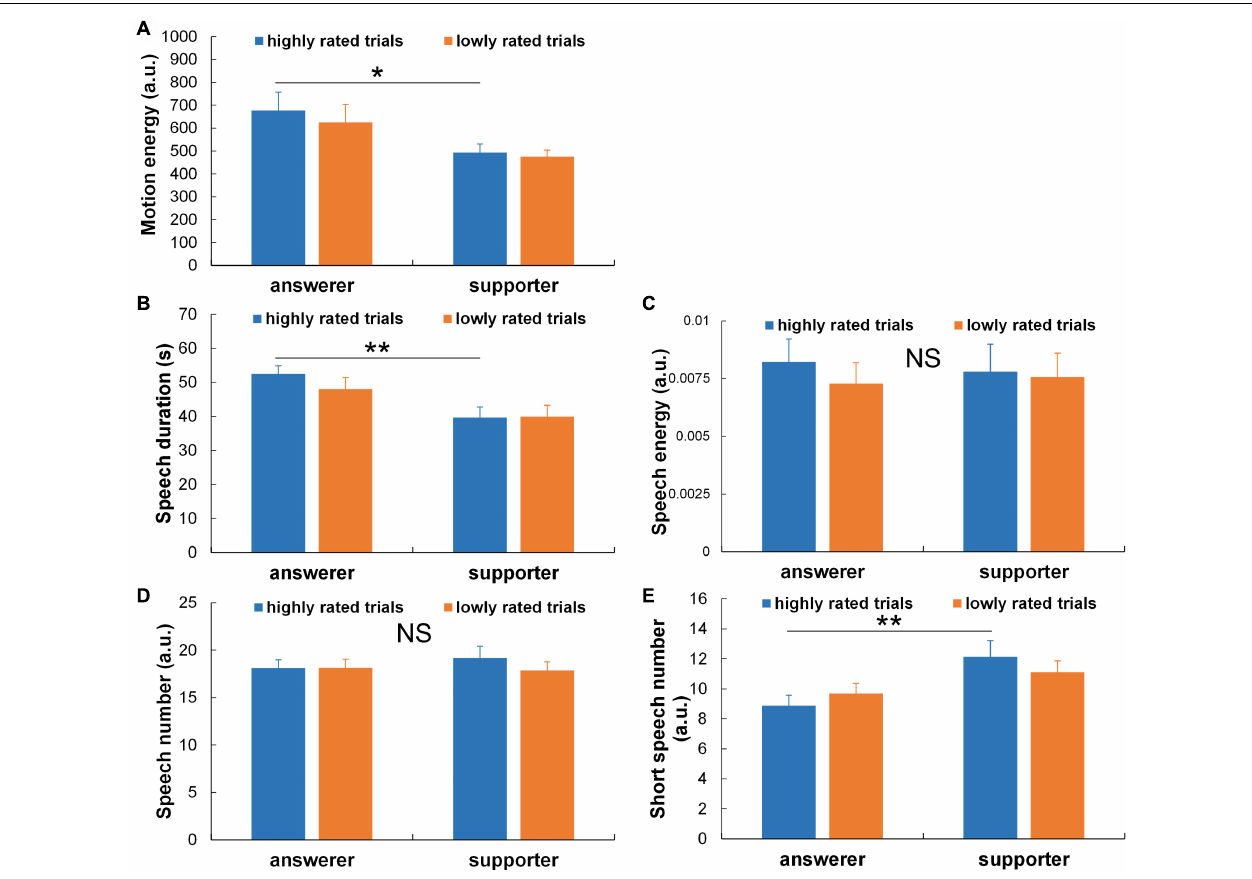
FIGURE 4 | Comparisons of behavioral activities between highly and lowly rated trials in terms of the subjective confidence in answers and between the answerer and supporter roles: (A) motion energy, (B) speech duration, (C) speech energy, (D) speech number, and (E) short speech number. ** p < 0.01; * p < 0.05. NS, not